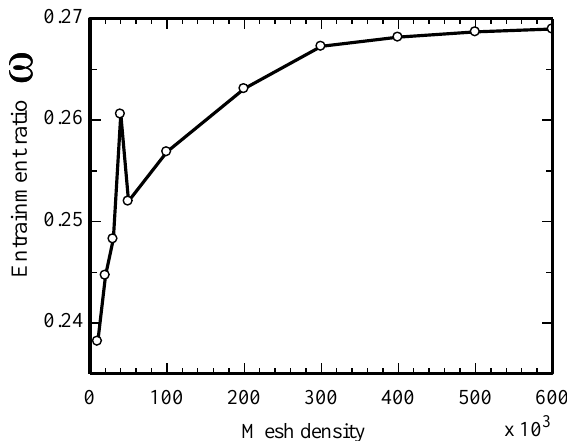
Figure 6. Mesh independence study .